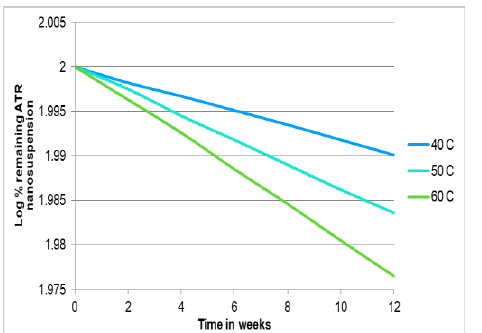
Figure 14. Rate of degradation of atorvastatin calcium nanosuspension freeze dried powder stored at three various temperatures.